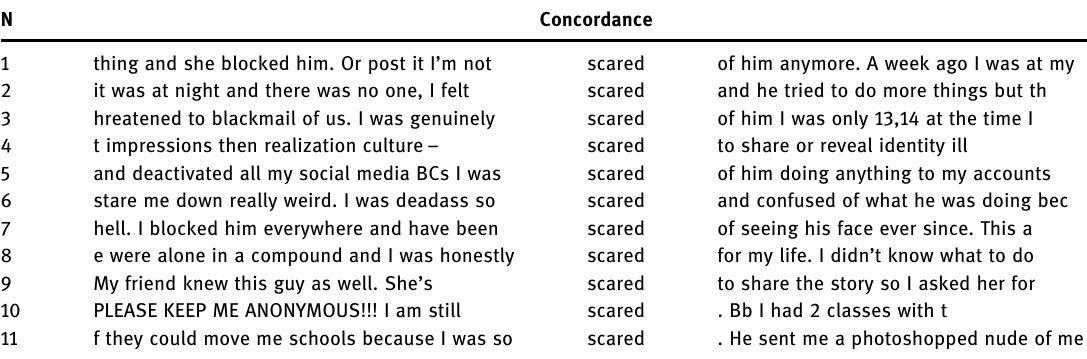
table with his sexual advances: Why? Never kissed a guy before ( line 5 ) , showing how, for ABZ, it was taken for granted that all girls had prior sexual experiences. As shown in Tables 25 and 26, all the uses of scared and terri fi ed have the victims as actors in the agent position. They are used to describe the victims ’ feelings during the process of being sexually assaulted and after.